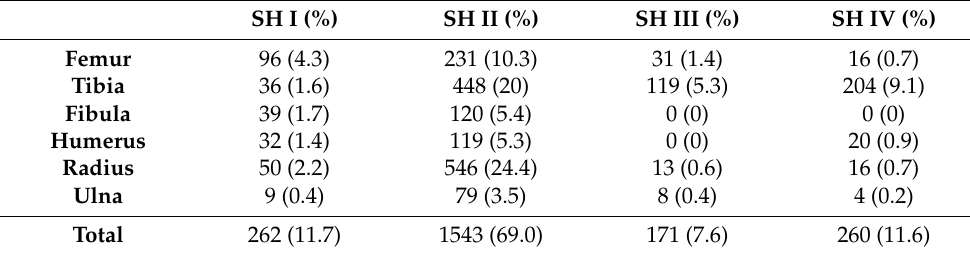
Table 5. Salter–Harris classification of physeal injuries based on long bone. N =